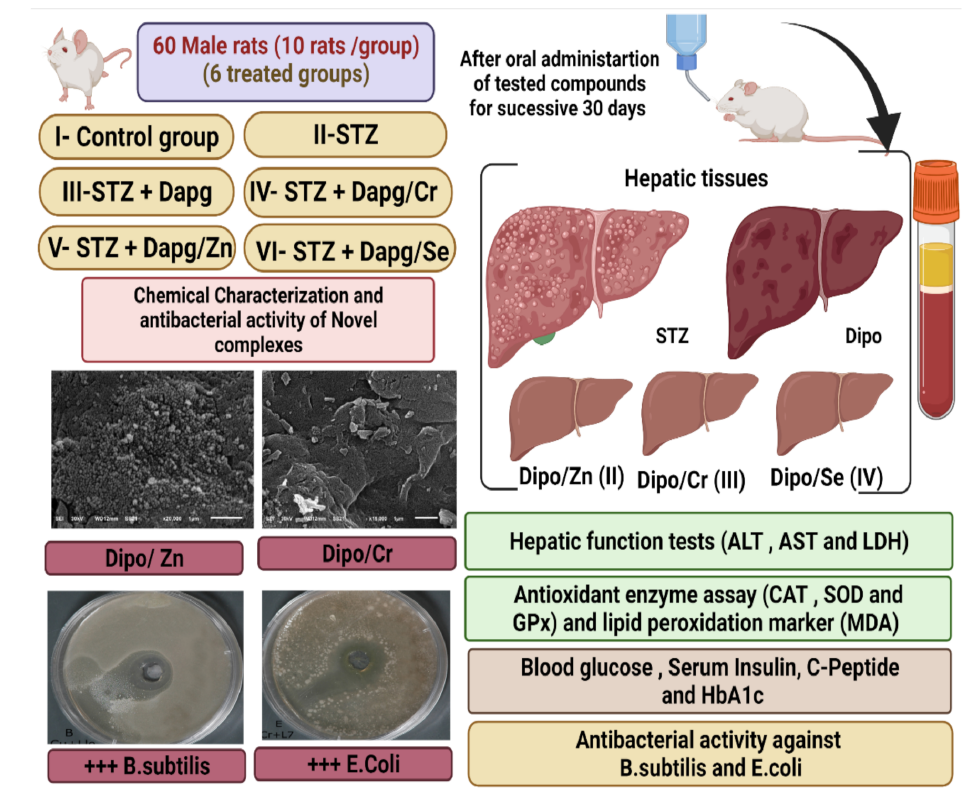
Figure 2. The experimental design and processes of the